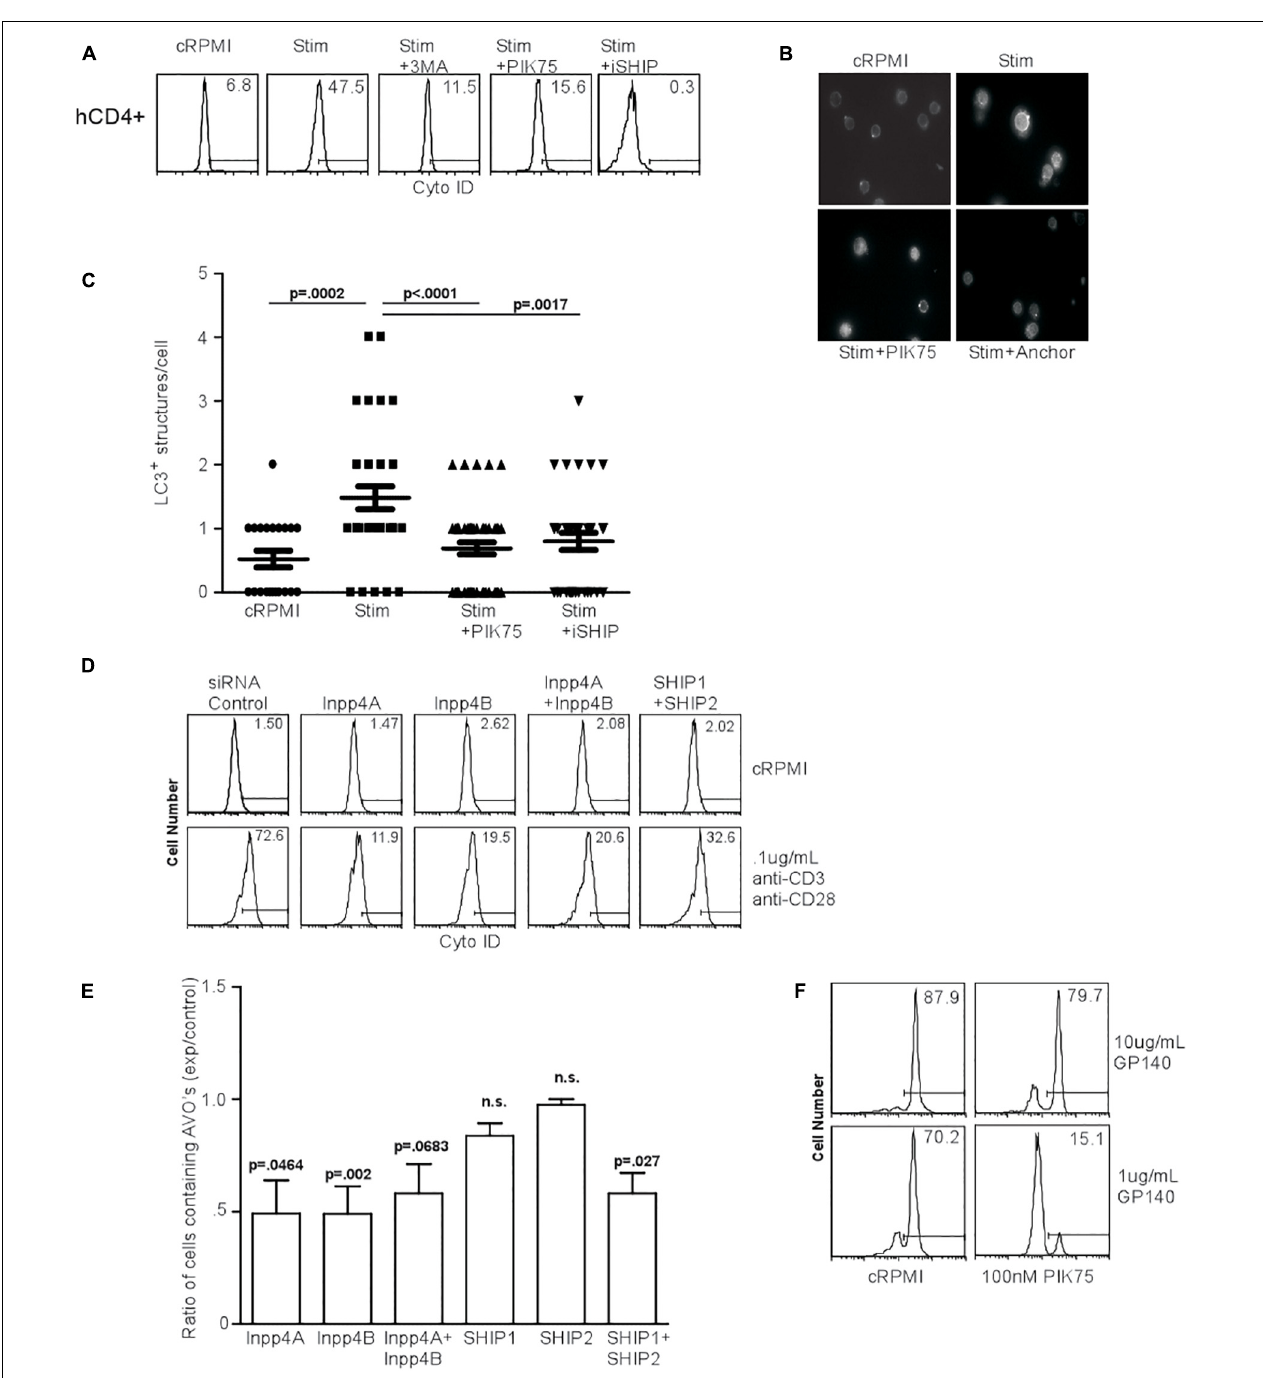
FIGURE 7 | Human T cell autophagy is dependent upon class I PI3K activity and inositol phosphatase activity. (A) AVO formation in human lymphocytes. Human CD4 + T cells were isolated from healthy donors, purified by Ficol gradient centrifugation, and stimulated with 0.5 µ g/mL anti-CD3 and anti-CD28 for 24 h. AVO formation was inhibited by 100 nM PIK75, 3MA, and 15 µ M Anchor. Data are representative of at least 3 independent experiments per condition. (B) LC3 punctate formation in stimulated human CD4 + T cells for 48 h as in (A), permeabilized, and stained for endogenous LC3. (C) Quantification of (B) , representative of two replicates with at least 30 CD4 cells counted per condition. (D) AVO formation in siRNA mediated knockdown of Inpp4A, Inpp4B, and both SHIP1 and SHIP2. Human CD4 + T cells were purified as in (A) and electroporated to allow uptake of 5 µ g/5 × 10 6 cells siRNA cocktails, allowed to recover in complete media for 72 h and stimulated with 0.5 µ g/mL anti-CD3 and anti-CD28 for 48 h. (E) Quantification of stimulated CD4 T cells in (D) , comparing the percentage of cells upregulating AVO formation in the siRNA knockdown samples to a scrambled control siRNA. Data are representative of cells from 5 donors in 4 independent experiments. (F) AVO formation in human CD4 + T cells exposed to soluble HIV GP140 fusion protein at the indicated concentrations. Total PBMC’s were treated with the glycoprotein and 100 nM PIK75 for 48 h.